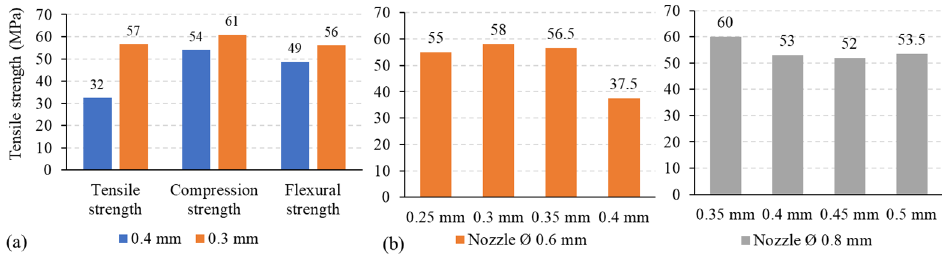
Figure 12. ( a ) PEEK tensile, compression and flexural strength sensitivity to layer thickness and ( b ) with different nozzle diameters (in mm).